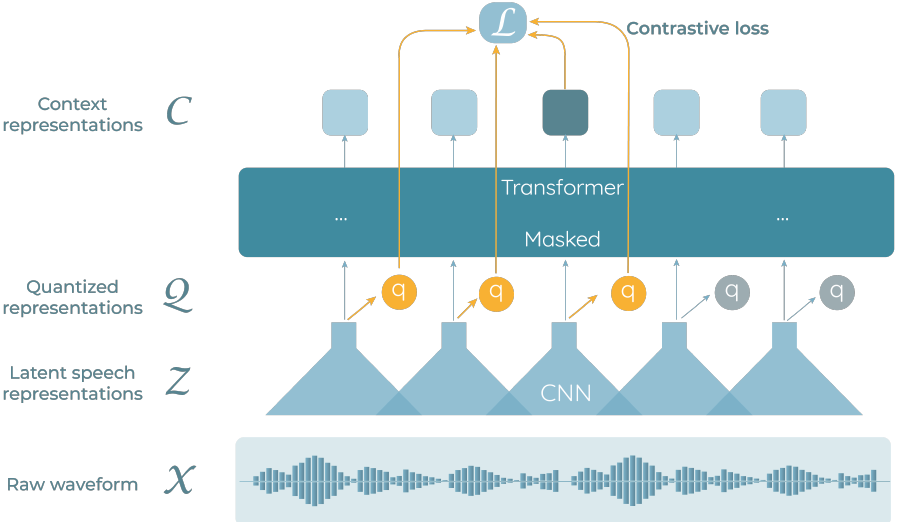
Figure 3. Wav2vec2.0 architecture representation. The raw audio signal is mapped to speech repre- sentations that are fed into a transformer network to output context representations. Context rep- resentations are then quantised to represent targets in the self-supervised task. This figure is based on the one presented in